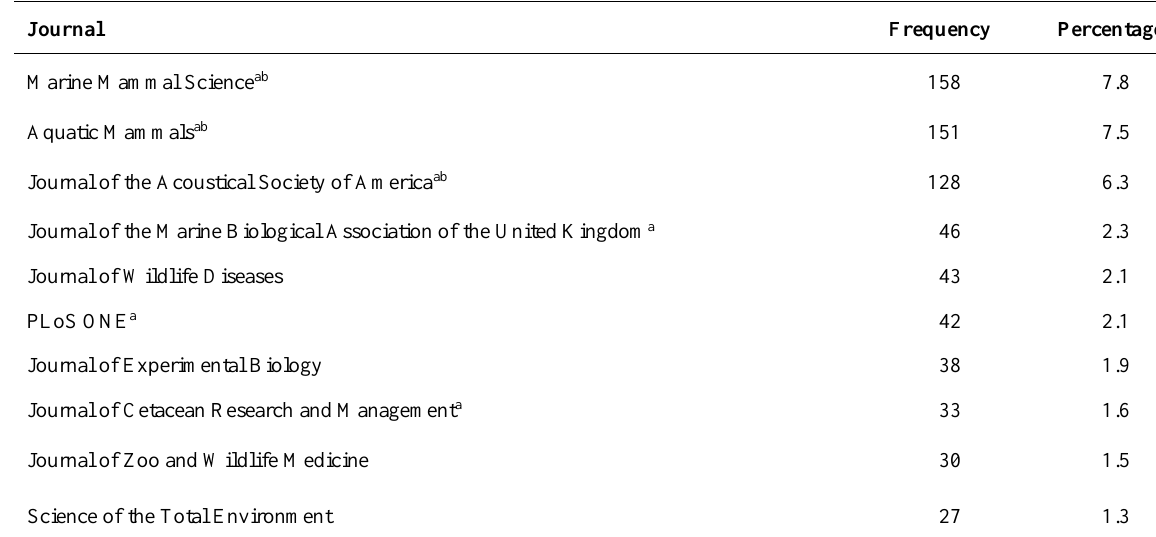
Top Ten Journals Publishing Dolphin Articles Most Frequently from the Study